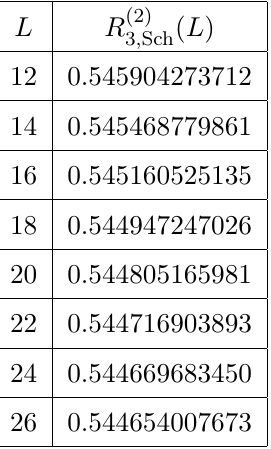
( L ) for some values of L > 3 ; Sch